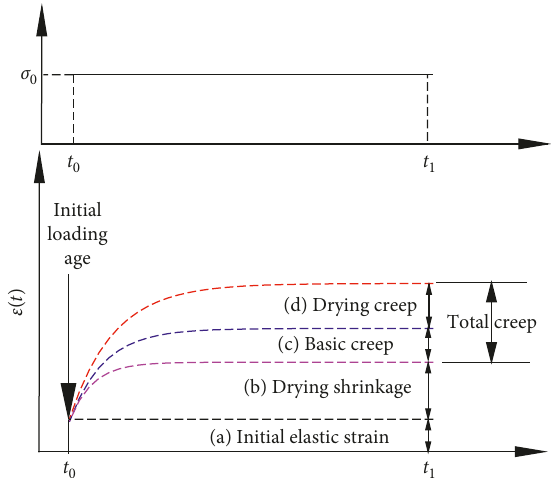
Figure 1: Sketch map of time-dependent strain of concrete under sustained